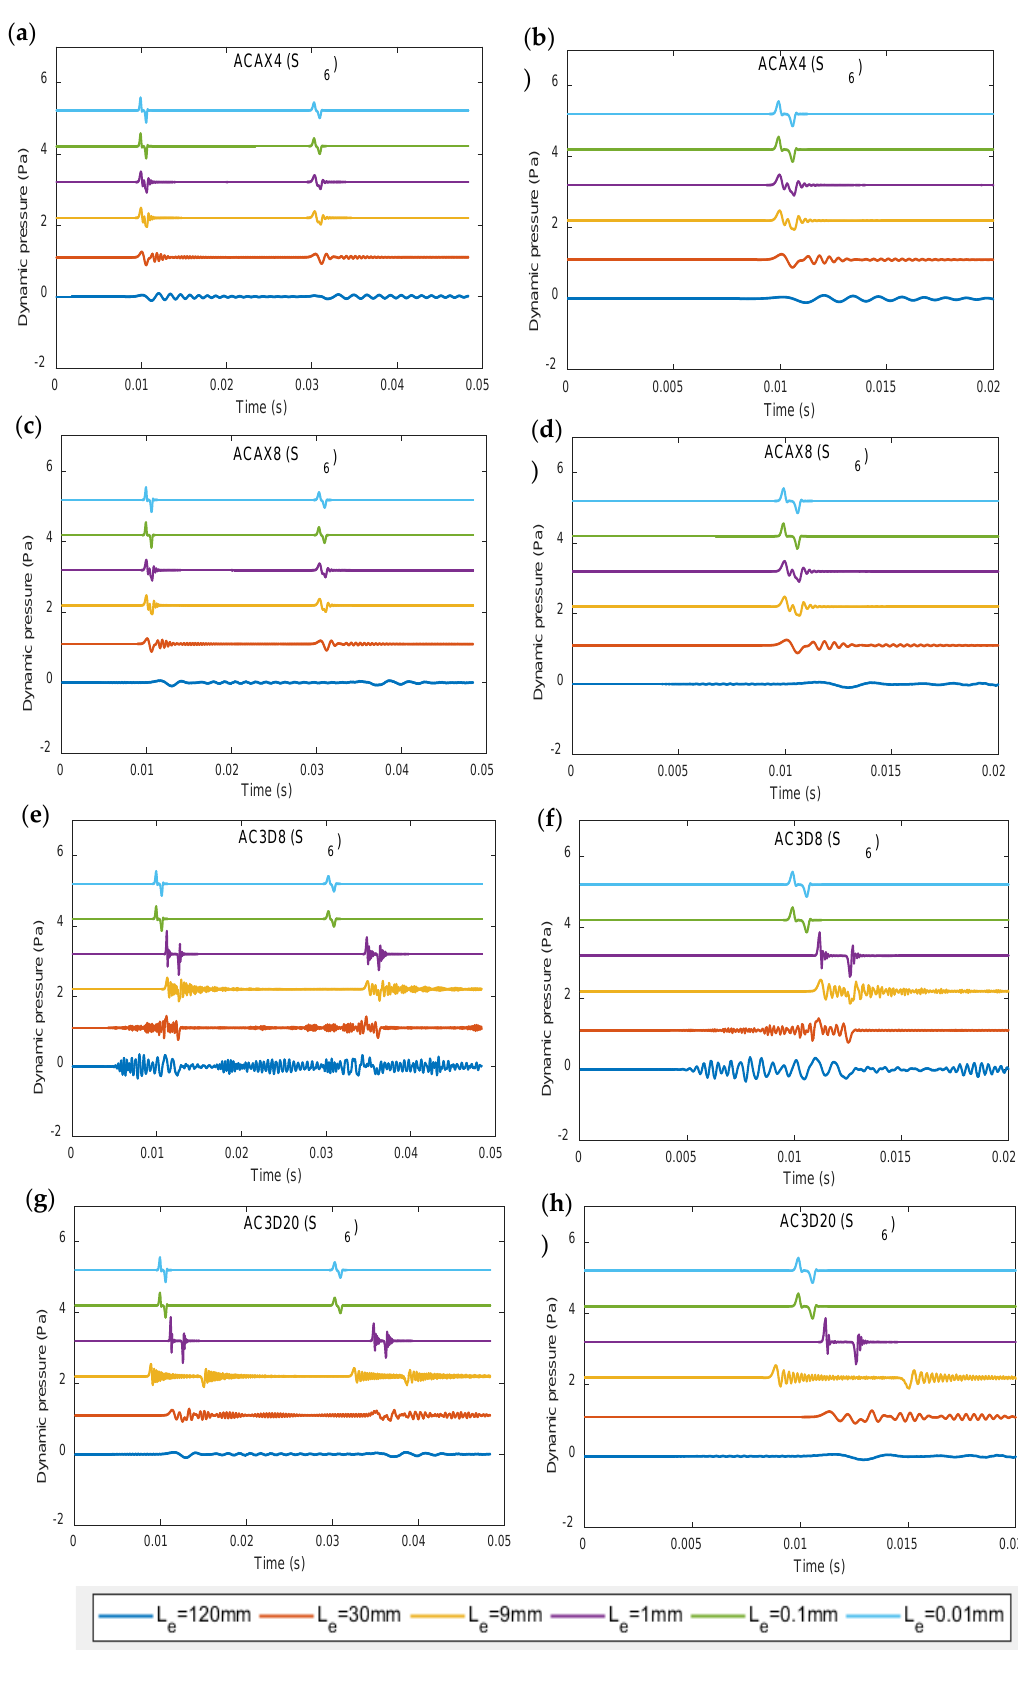
using ACAX4, ACAX8, AC3D8 and 𝑟𝑟 6 𝑟𝑟 6